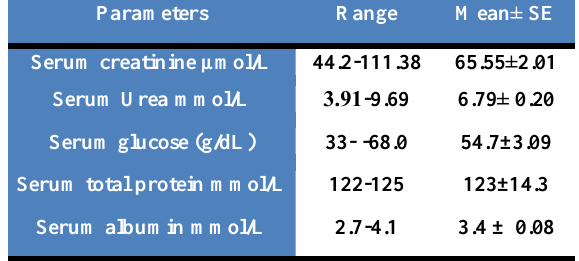
Table, 1: Biochemical parameters (Serum creatinine, urea glucose, total protein and albumin concentra - tions) for Iraqi donkeys (Range and Mean±